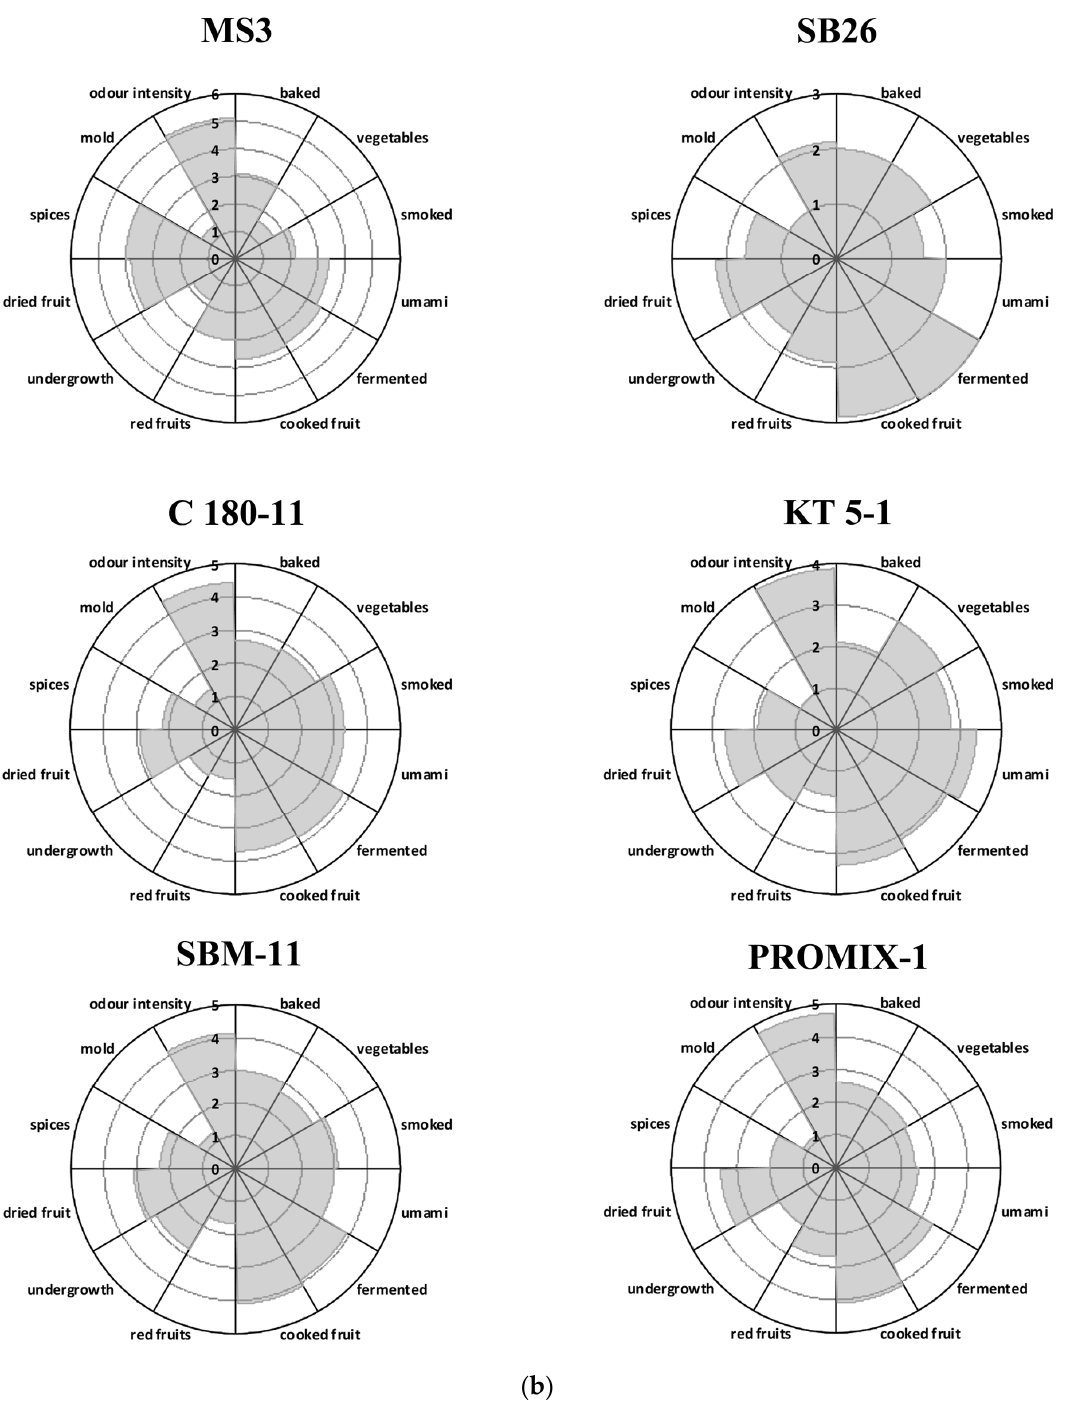
Figure 5. ( a ) Effects of fermentation by yeast starter cultures on odor characteristics of jellyfish-based food products. Jelly paste ( A. oryzae ): product obtained by the first fermentation step (solid-state fermentation) performed by inoculating the Koji starter ( A. oryzae ) into Jellyfish puree (consisting of Jellyfish, starch, and wheat bran). SF: spontaneous fermentation of uninoculated Jelly paste, as control; LI 180-7: Saccharomyces cerevisiae ; Y1D: Metschnikowia sp . ; YB51: Candida parapsilosis ; BC T3-23: Debaryomyces hansenii . ( b ) Effects of fermentation by bacterial starter cultures on odor characteristics of jellyfish-based food products. MS3: Bacillus amyloliquefaciens ; SB26: Staphylococcus pasteuri ; C 180-11: Lactiplantibacillus plantarum , KT 5-1: Leuconostoc mesenteroides . SBM-11: Lactobacillus sakei , Staphylococcus carnosus and S. xylosus ; PROMIX-1: S. xylosus .